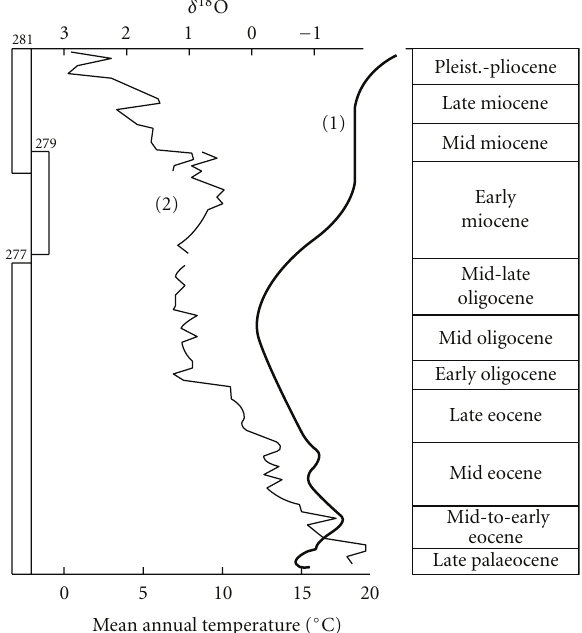
Figure 3: Variations in surface water temperatures during the Cainozoic: (1) in the near-shore, north-eastern Australian region (adapted from Feary et al. [47]) and (2) on the Campbell Plateau in the South Tasman Rise (after Shackleton and Kennett